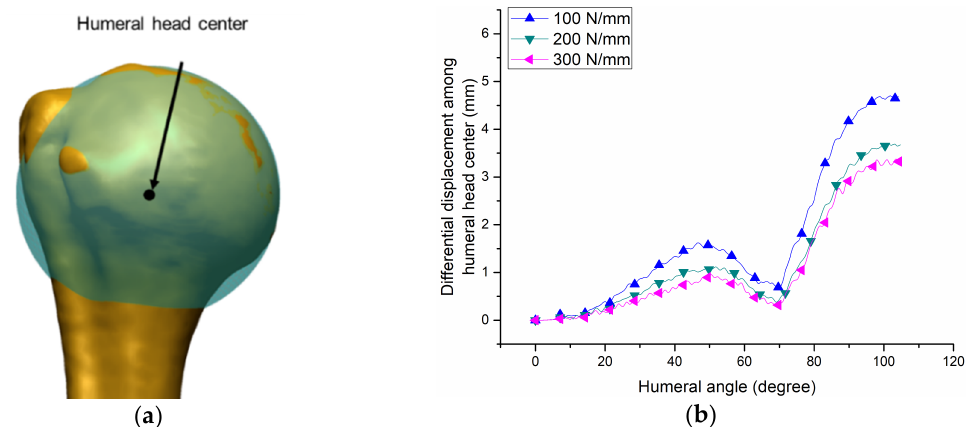
Figure 8. The analysis of differential displacement among humeral head center of guidance and follower: ( a ) Definition of humeral head center; ( b ) Change of the differential displacement among humeral head center of guidance and follower according to humeral angles.